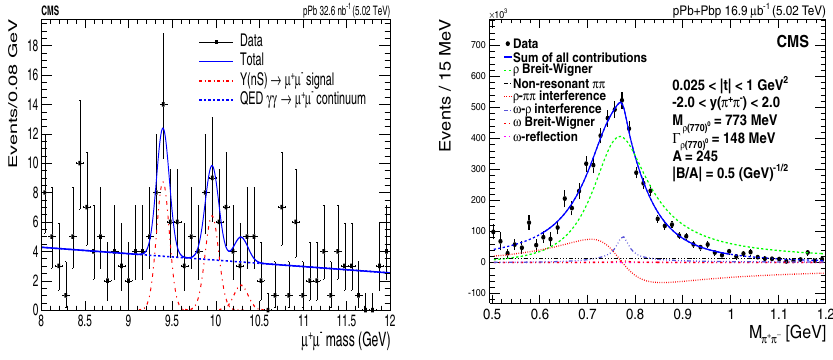
Figure 1. The left-side figure shows the invariant mass distribution of the exclusive dimuon candidates < 12 GeV that satisfy all the selection criteria, fitted to a linear function for in the range 8 < m µ + µ − the two-photon QED continuum (blue dashed line) plus three Gaussian distributions corresponding to the Υ (1S) , Υ (2S) , Υ (3S) mesons (dashed-dotted-red curves). The right-side figure shows the unfolded π + π − invariant mass distribution [4] in the pion pair rapidity interval y π + π < 2 fitted with the Söding − | | model [7]. The green dashed line indicates resonant ρ (770) 0 production, the red dotted line represents π + π − π 0 , the interference term, the magenta dash-dotted line corresponds to the background from ω → the black dash-dotted line represents the non-resonant contribution, and the blue solid line represents the sum of all these